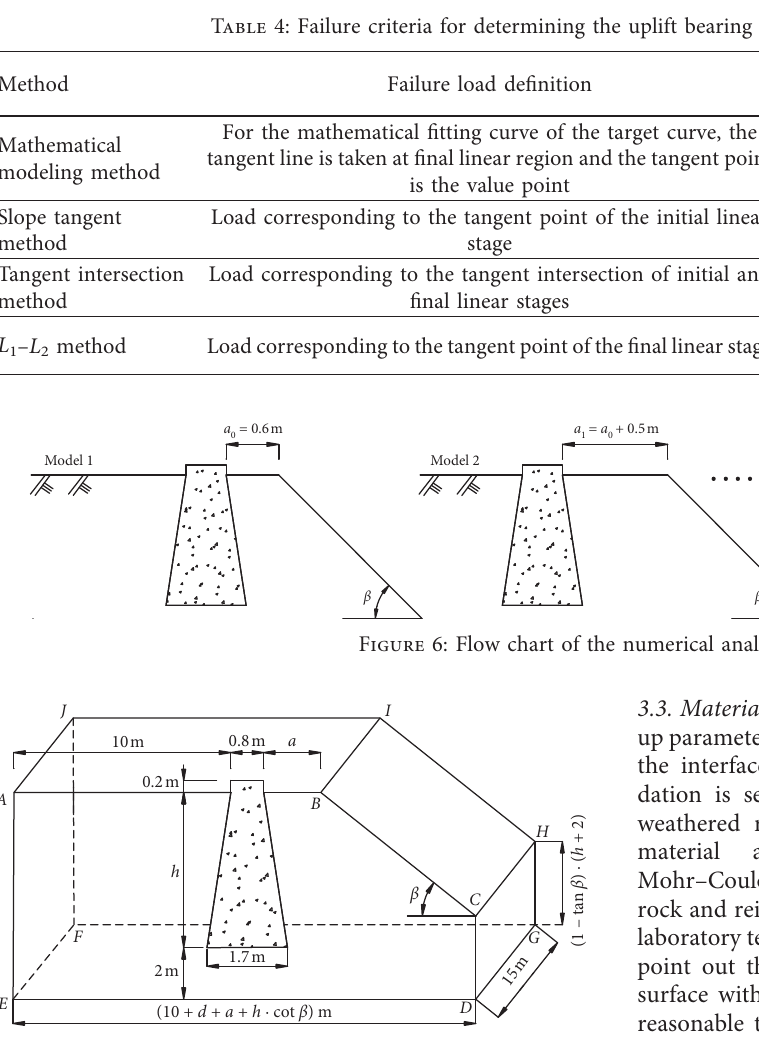
Figure 7: Geometrical dimensions of the slope-foundation model.